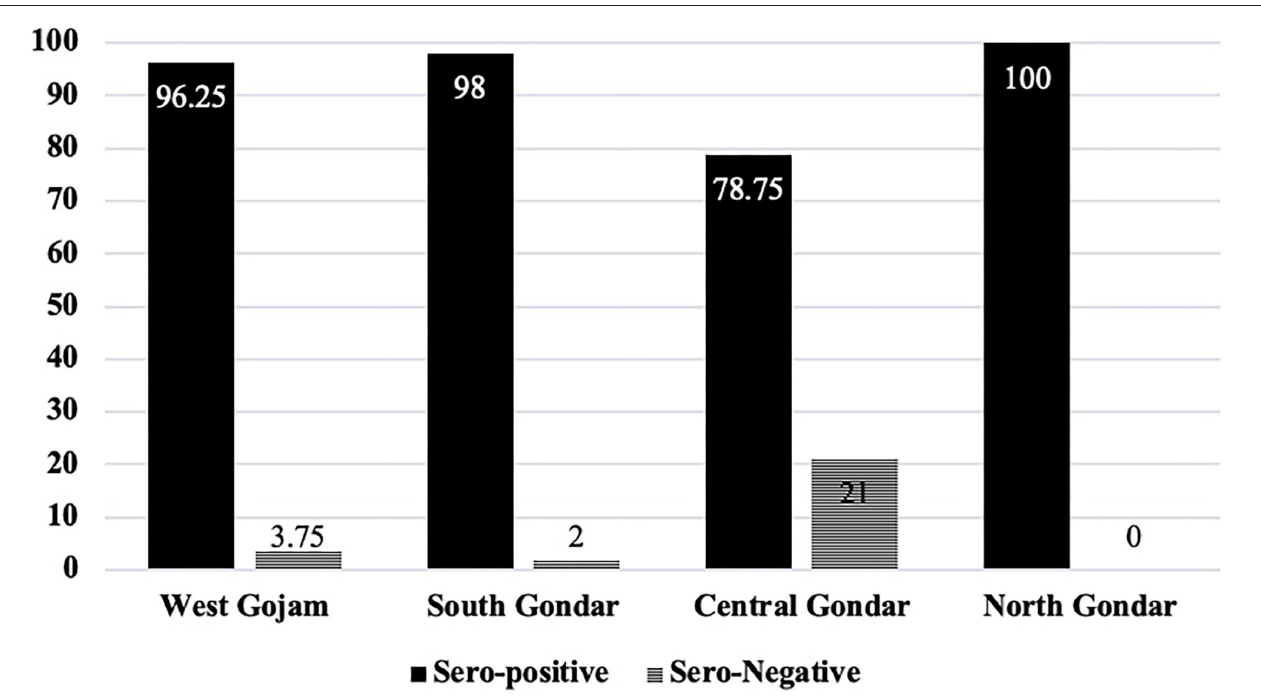
FIGURE 2 | Seroprevalence (%) of ovine pasteurellosis in the four zones of West Amhara region. Serum was obtained from those zone as followed, West Gojam ( n = 160), South Gondar ( n = 100), Central Gondar ( n = 240), and North Gondar ( n = 100). IHA test was performed in each serum to determine the presence of serotype-specific antibody reactions. An animal is considered sero-positive if it tested positive for at least one of the six (6) serotypes examined (A1, A2, A7, T4, T15, and PA). The district-level prevalence was 96.25% (West Gojam), 98% (South Gondar), 78.75% (Central Gondar), and 100% (North Gondar) ( p = 0). PA = Pasteurella multocida biotype A